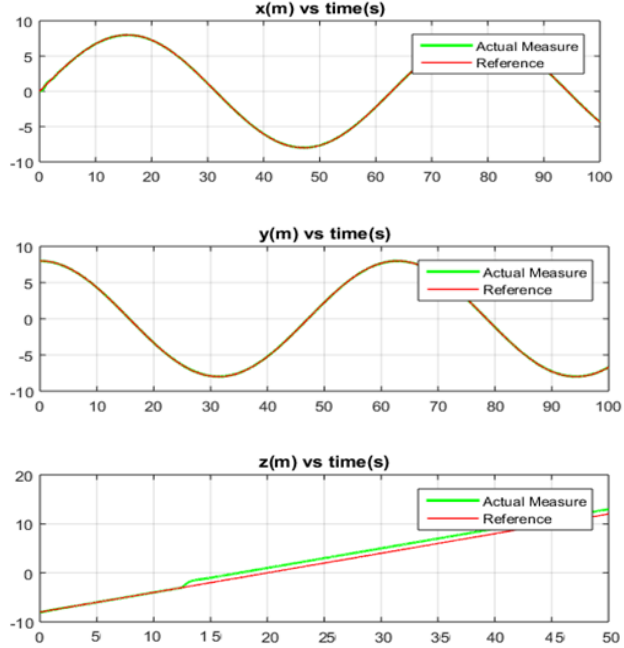
Figure 13. Position response derived using F-SMC control technique.